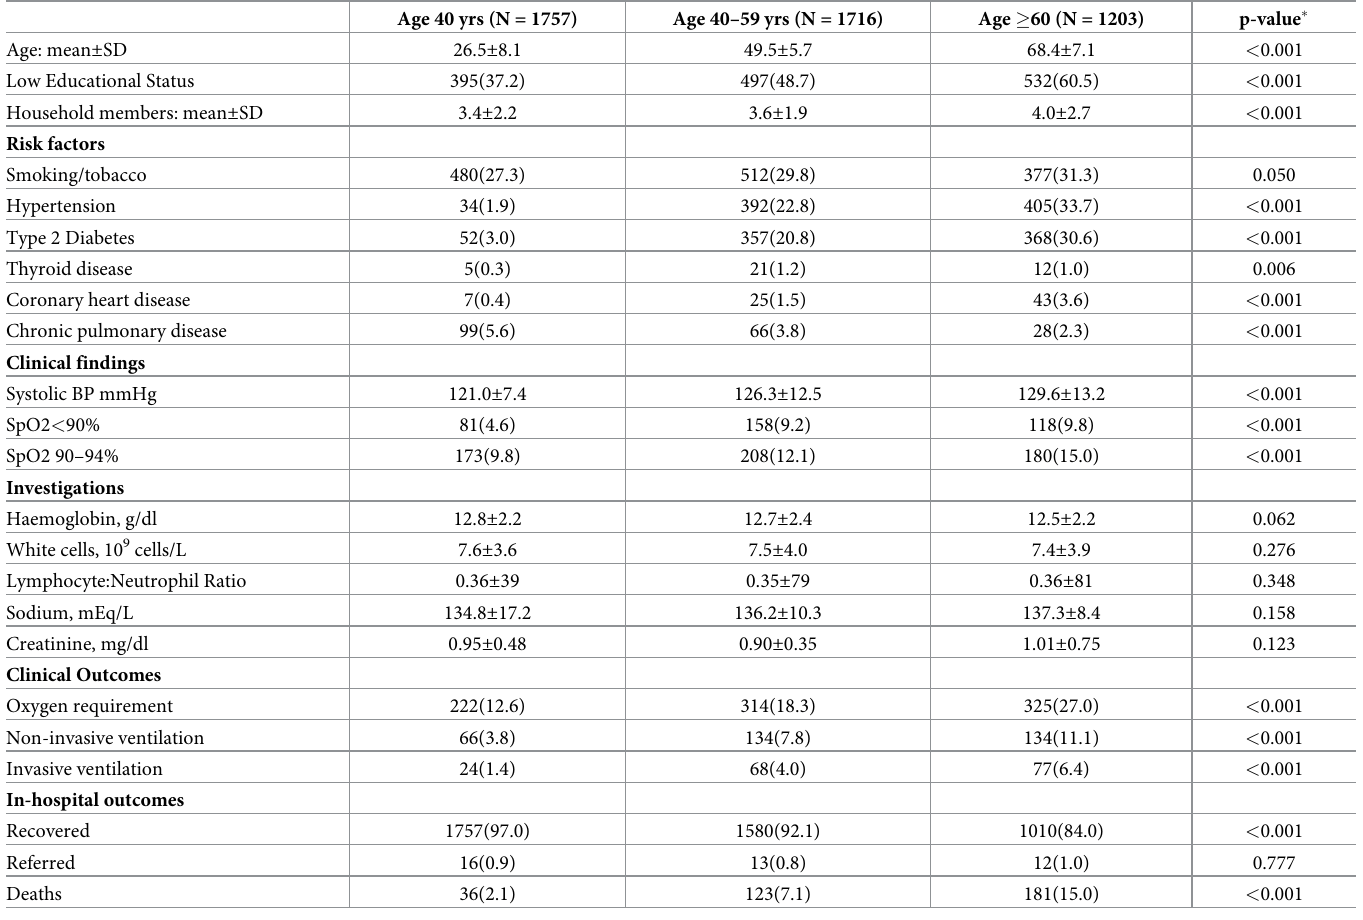
Table 1. Clinical characteristics and outcomes in age-groups < 40 years, 40–59 years and � 60 years.